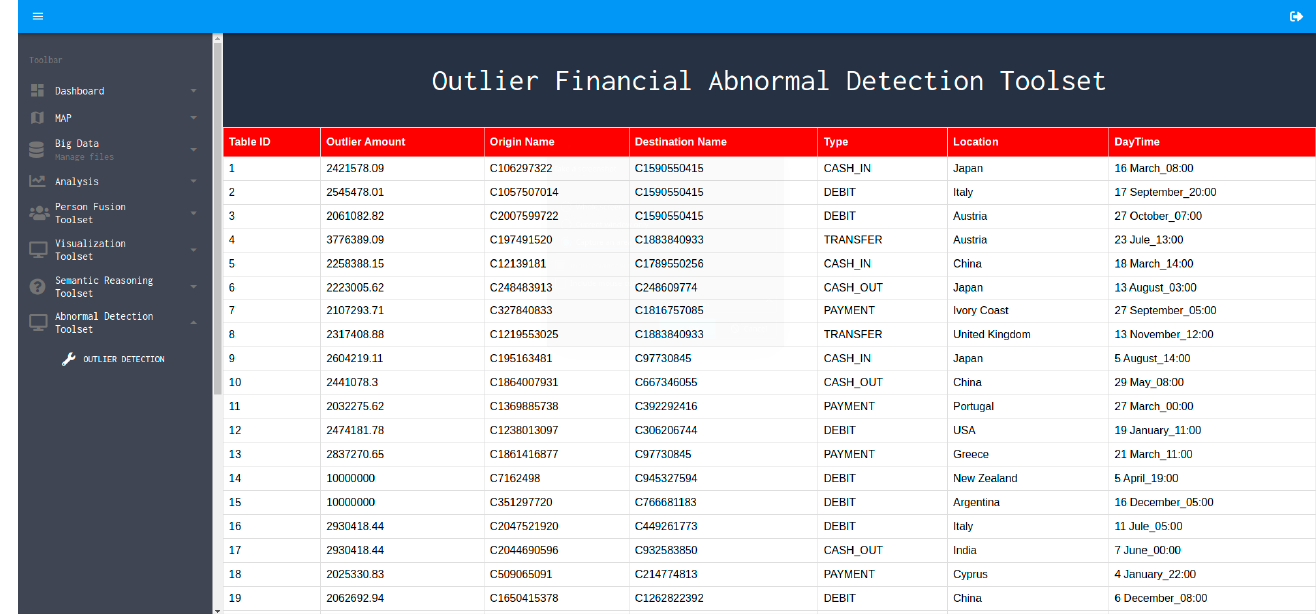
Figure 4. Financial outlier detection table.